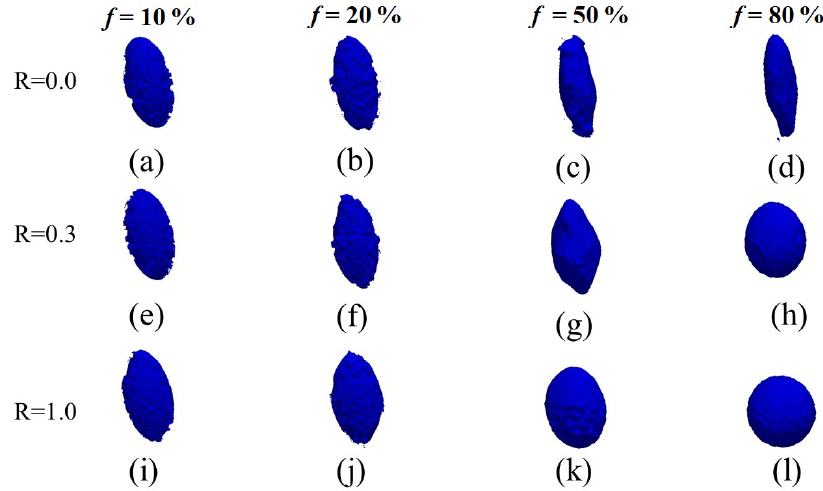
Figure 2. The typical morphologies of simulated dust.